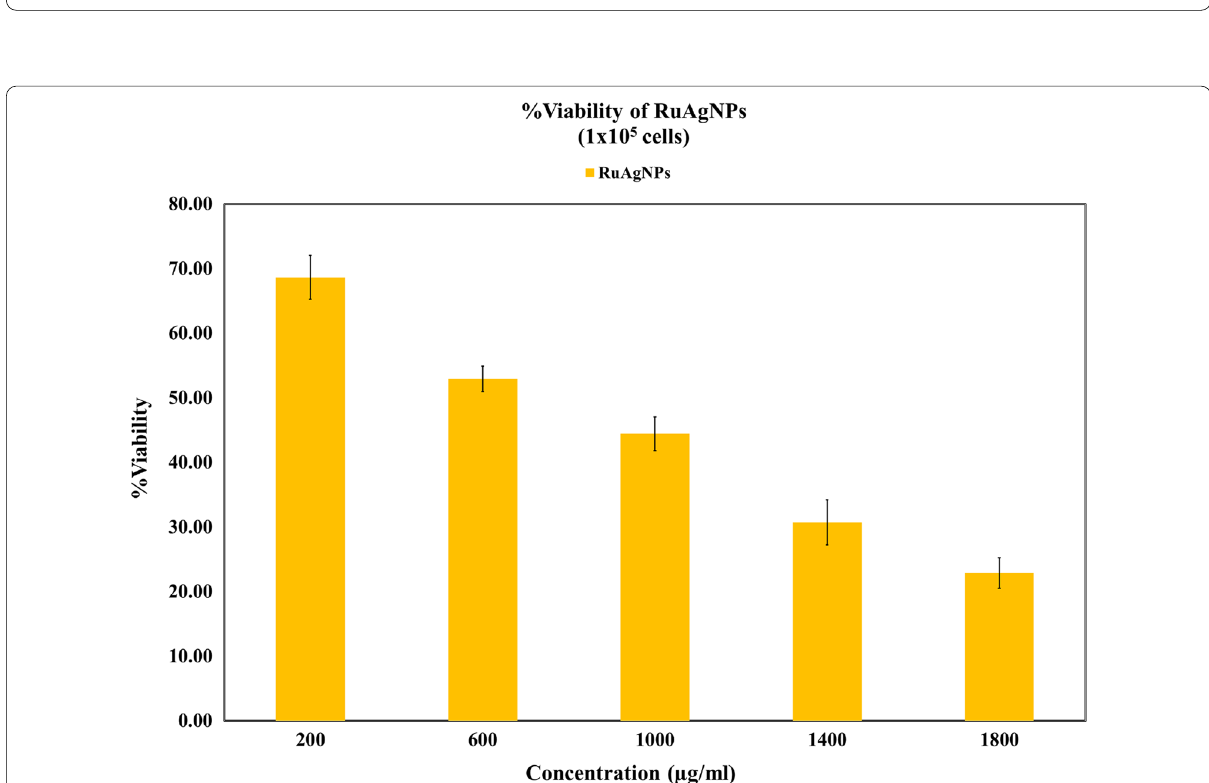
Fig. 15 Cytotoxic assessment of AgNPs using MTT